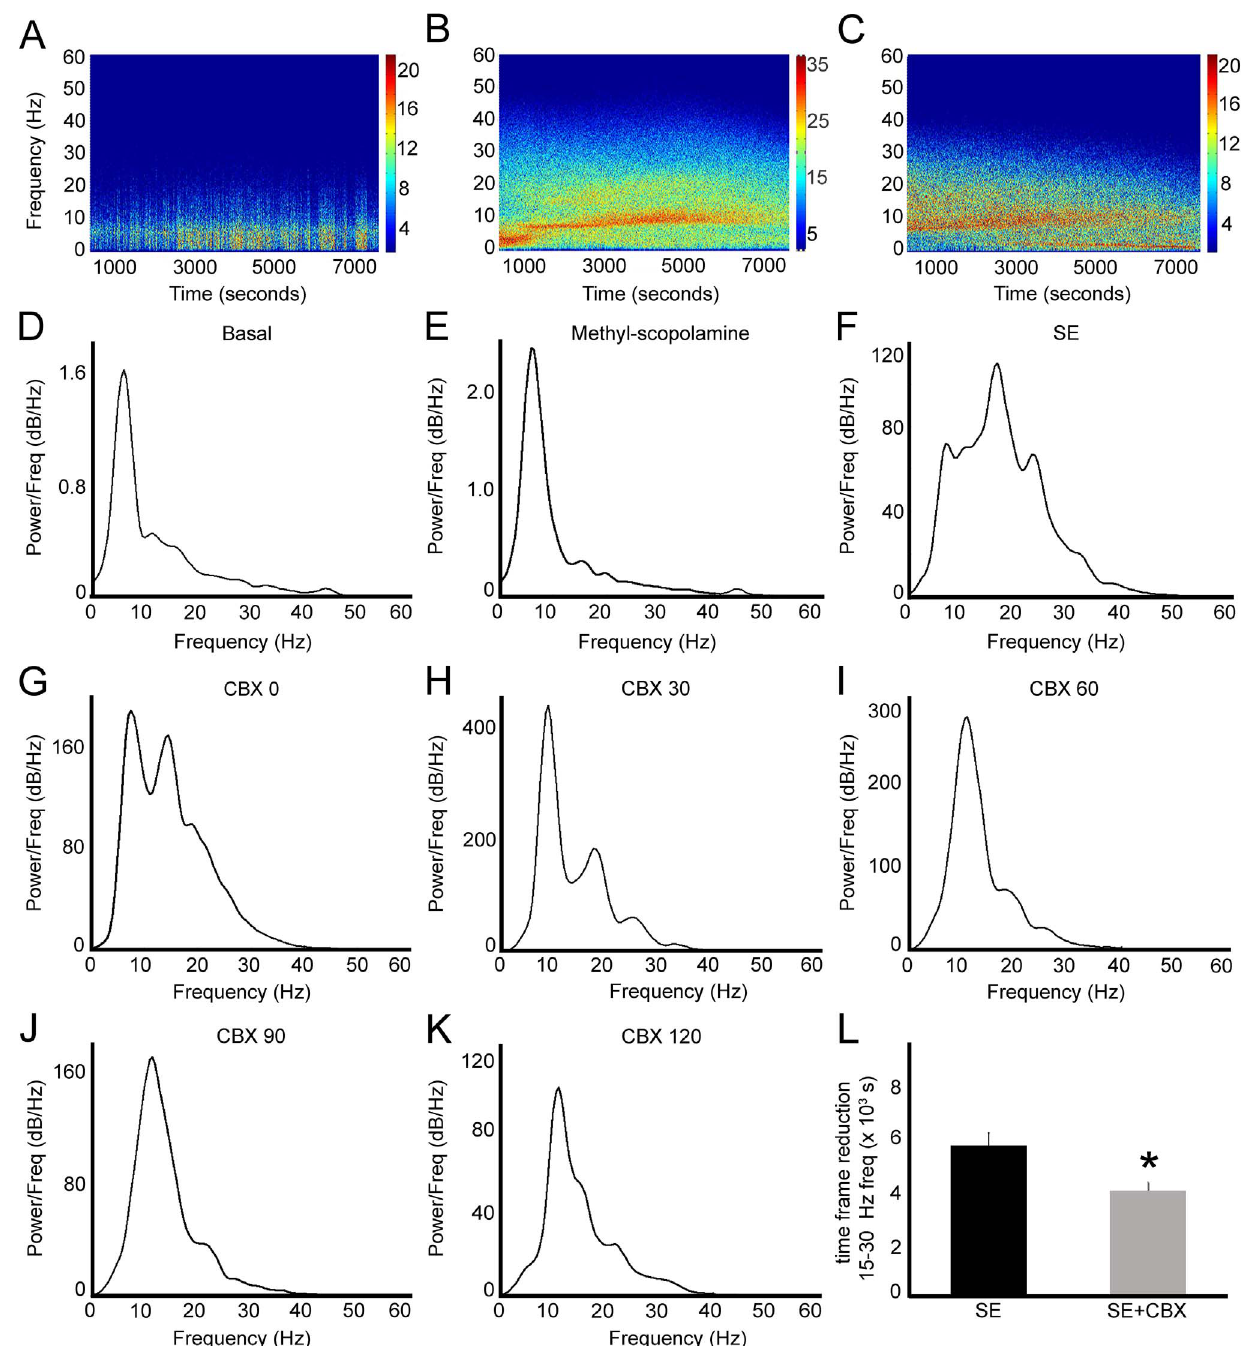
Figure 2. Effects of pharmacological blockade of GJ channels on epileptiform potentials during status epilepticus (SE). (A, B, C) Representative spectrograms of the raw ECoGs from Control CBX, SE and SE + CBX groups, showing the main frequencies, evidenced by the color intensity, which compose the signal during the 2-hour interval after injection of CBX or saline. Note the increase of ECoG power in the SE group (B) and the reduction of color intensity after CBX treatment (C), showing the decrease of power of all frequency bands, especially the beta frequency. Representative power spectra of SE + CBX group. (D, E) Power spectrum of basal and methyl-scopolamine periods shows similar frequency composition. (F) It is possible to observe that pilocarpine-induced SE enhanced the power of all frequency bands, especially at 12–35 Hz range. (G–K) CBX administration 30 minutes after SE establishment caused notable decrease of the power in the beta frequency oscillations observed in the following 2 hours. Since we found that the reduction of beta oscillations occurs during the evolution of SE (data not shown), we tested whether this reduction was significant when compared to the same periods of SE group. (L) We observed that the time period for reduction in the beta frequency range was significantly decreased in the animals that received CBX injection. Bars represent standard errors of mean. * P , 0.01 in T-Test.